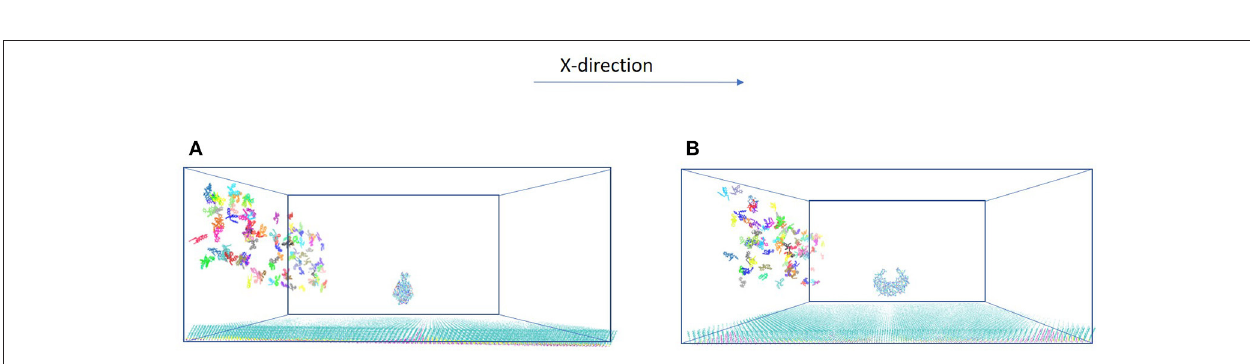
gives an average chain separation of 4.98 Å. The system had